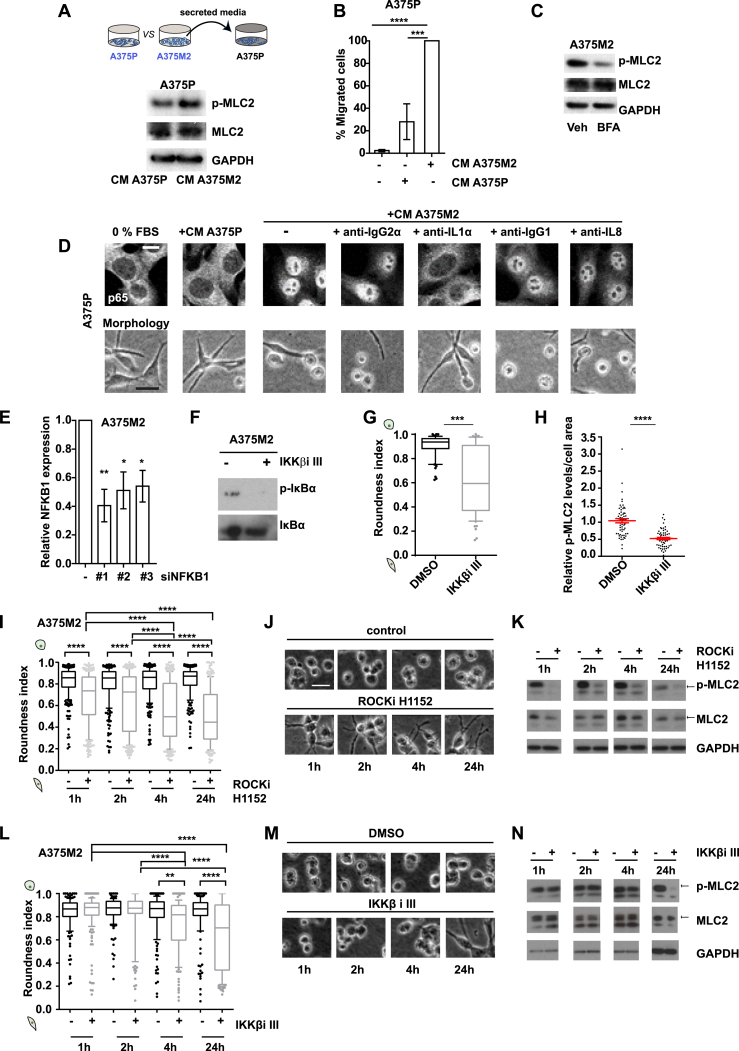
Myosin II Activity in Cancer Cells Self-Perpetuates via Secreted IL-1α-Induced NF-κB Activation, Related to Figure 6(A) (Top) Schematic illustrates the treatment of A375P cells with CM A375M2 and (bottom) representative immunoblot for p-MLC2 in A375P cells after treatment with CM A375M2.(B) Percentage of migrated A375P cells after treatment with CM A375P, CM A375M2 or media only (-). Data are presented versus CM A375M2 treatment (n ≥ 3).(C) Representative immunoblot for p-MLC2 in A375M2 cells after treatment with BFA for 6h.(D) (Top) Representative confocal images and (bottom) bright-field images, showing p65 localization and cell morphology, respectively, in A375P cells treated with CM A375P, CM A375M2, IgG2α-blocked CM A375M2, IL-1α-blocked CM A375M2, IgG1-blocked CM A375M2 or IL-8-blocked CM A375M2. Blocking was for 1h at 37°C. Scale bar, 10μm for confocal images and 20μm for bright-field images.(E) Relative NFKB1 levels in A375M2 cells after NFKB1 knockdown.(F) Representative immunoblot for p-IκBα after treatment of A375M2 cells with IKKβ inhibitor.(G) Roundness index and (H) relative p-MLC2 levels, in A375M2 cells after treatment with IKKβ inhibitor.(I) Roundness index (n = 3), (J) representative bright-field images and (K) representative immunoblots for p-MLC2, in A375M2 cells seeded on bovine collagen I upon treatment with the ROCKi H1152 (5 μM) for 1h, 2h, 4h or 24h.(L) Roundness index (n = 3), (M) representative bright-field images and (N) representative immunoblots for p-MLC2, in A375M2 cells seeded on bovine collagen I upon treatment with the IKKβ inhibitor IKKβ III (0.5 μM) for 1h, 2h, 4h or 24h.(B, E, and H) Graphs and dot blots show mean ± SEM. (G, I, and L) Boxplots show 10-90 percentile. (B, E, I, and L) One-way ANOVA with Tukey post hoc test. (G and H) t test.∗p < 0.05,∗∗p < 0.01,∗∗∗p < 0.001,∗∗∗∗p < 0.0001.